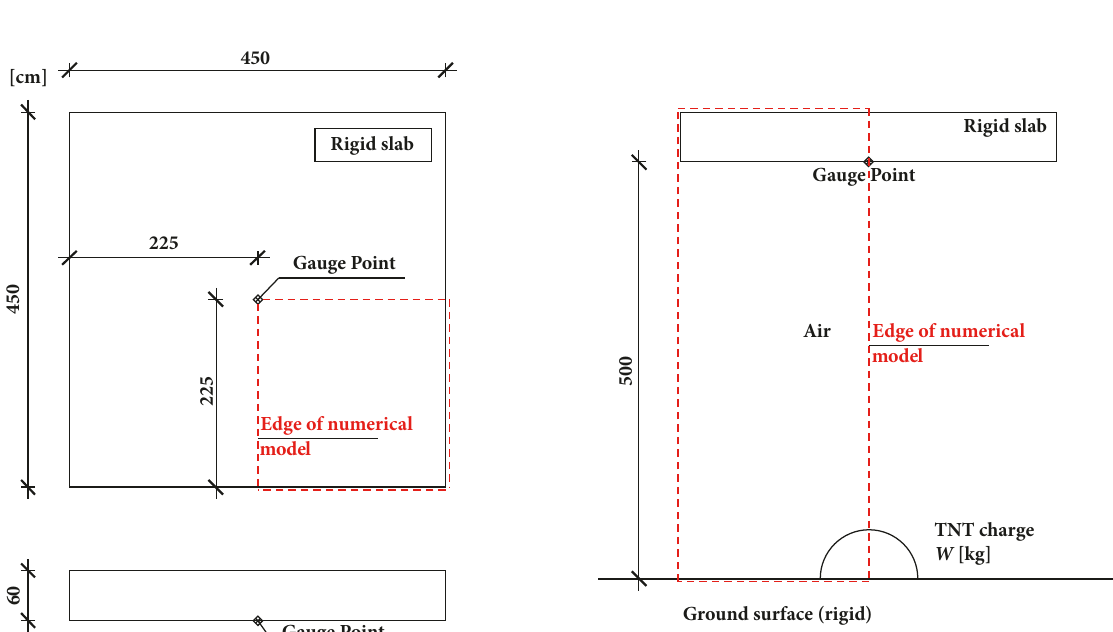
Figure 2: Free-air axisymmetric explosion model.